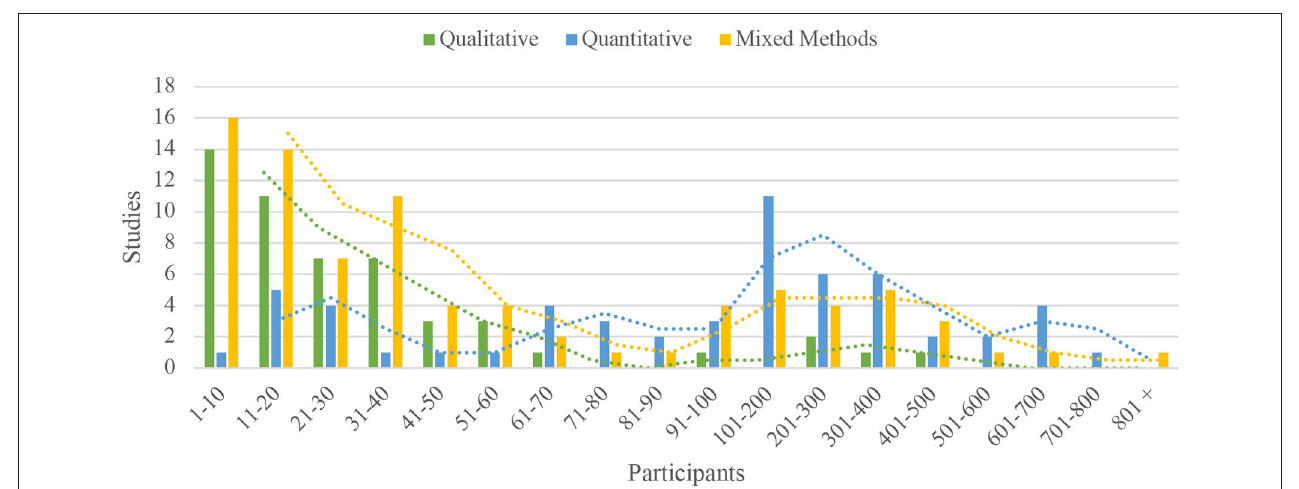
FIGURE 3 | Participant number by research design type (grouped by tens then